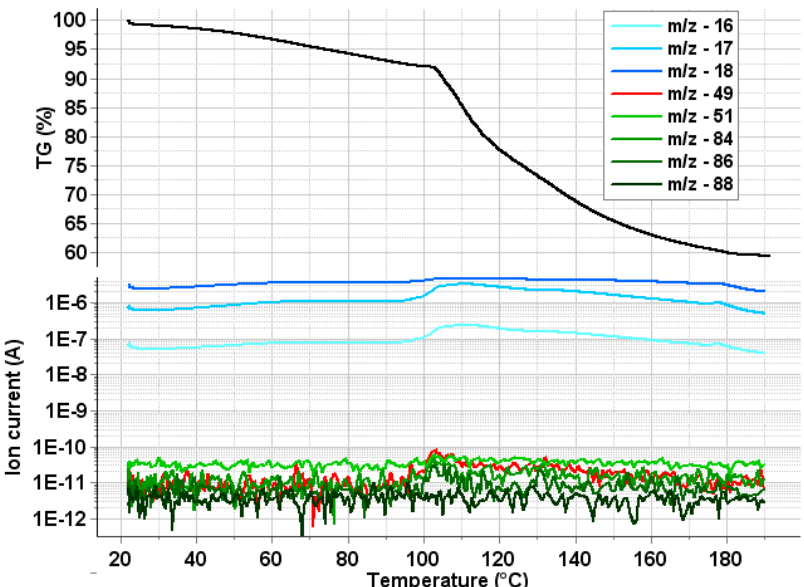
Figure 6. Mass (TG—upper part of the figure) and main characteristic ions of DCM (lower part of the figure).